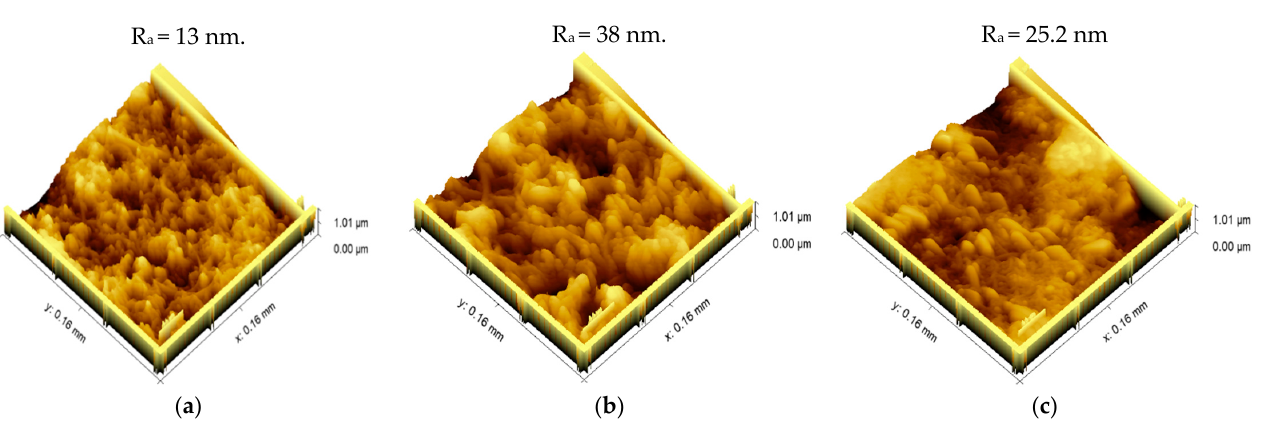
Figure 6. Atomic force microscopy images of ( a ) bare MWCNT/AuNPs, ( b ) immobilized aptamer /MWCNT/AuNPs and ( c ) PSA/MCH/aptamer/AuNP/MWCNT. /MWCNT/AuNPs and ( c )